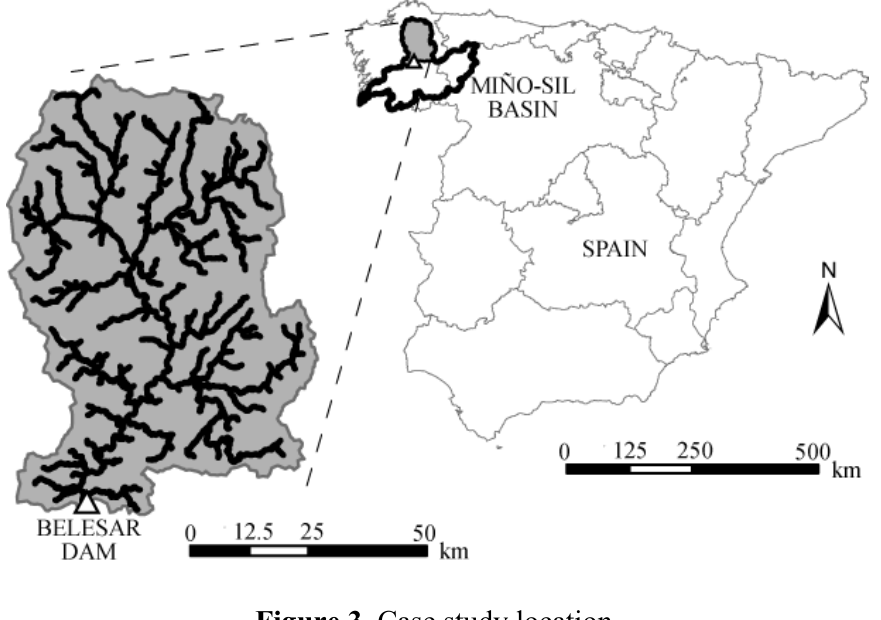
Figure 3. Case study